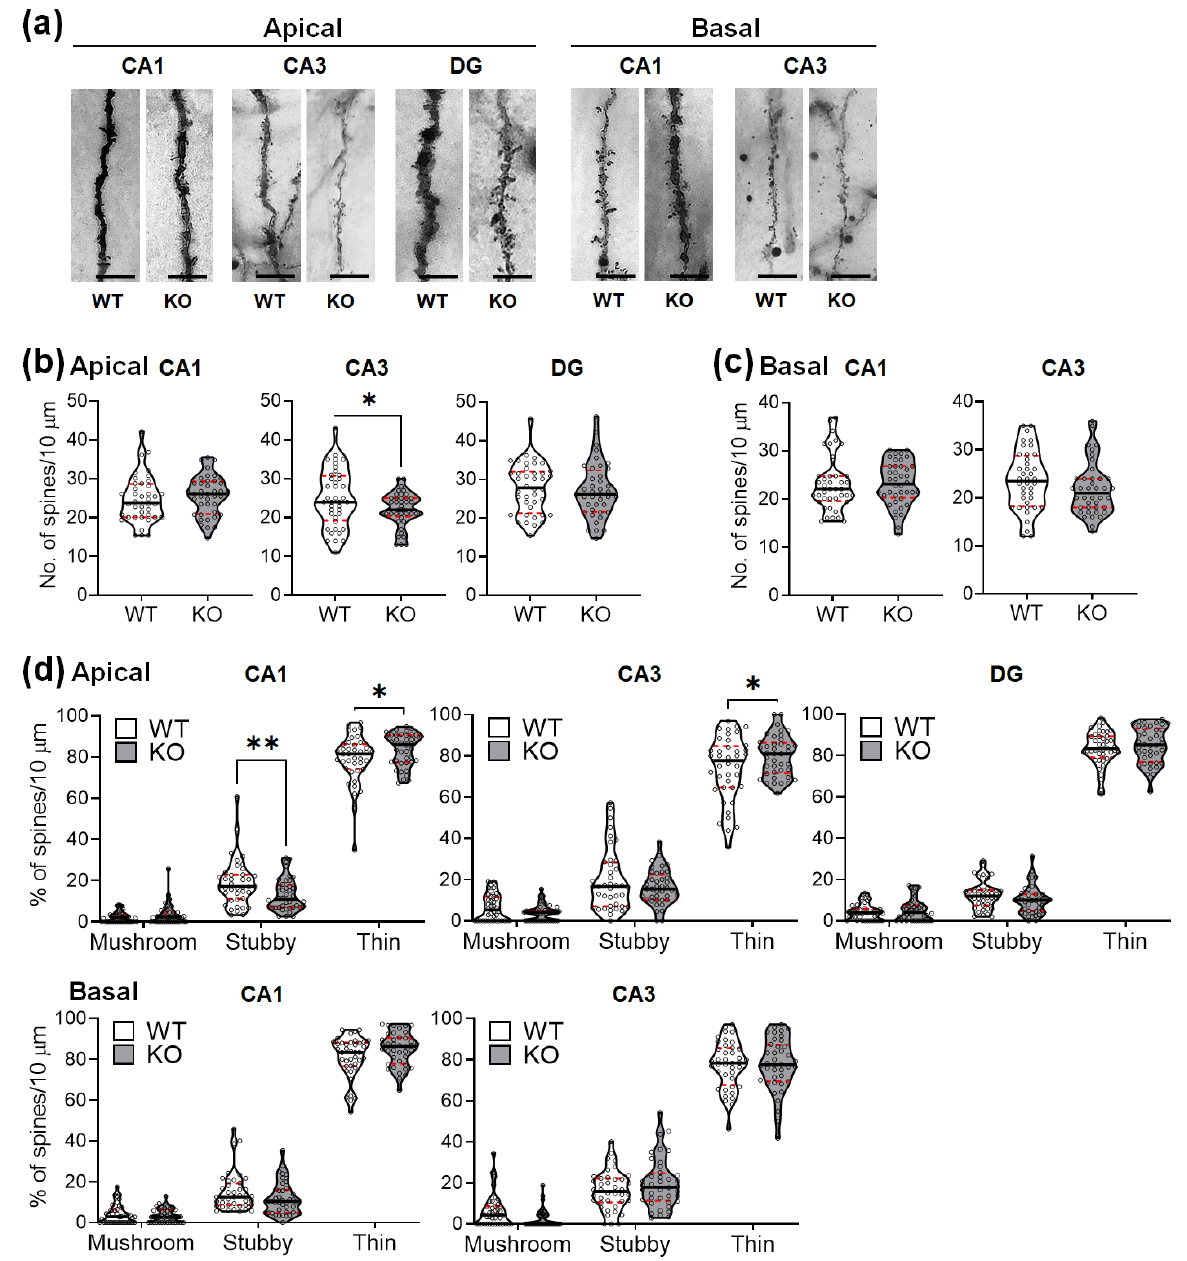
Figure 4. SREBP-1c KO mice show altered dendritic spine density and morphological proportions in the hippocampus. Representative images from each cohort show dendritic segments and their spines along Golgi-impregnated neurons ( a ). Violin plots show the total number of spines in each subregion (CA1, CA3, and DG) ( b , c ). Violin plots show the proportions of the spines categorized by morphology in each subregion (CA1, CA3, and DG) ( d ). Upper and lower dashed red lines signify the upper and lower quartiles, respectively, and the median is represented by a solid black line within a violin plot. * p < 0.05, ** p < 0.01 vs. WT ( n = 40 dendritic segment/group). The scale bars in the dendritic images represent 5 µ m. CA, cornu ammonis ; DG, dentate gyrus; WT, wild-type littermate; KO, SREBP-1c KO